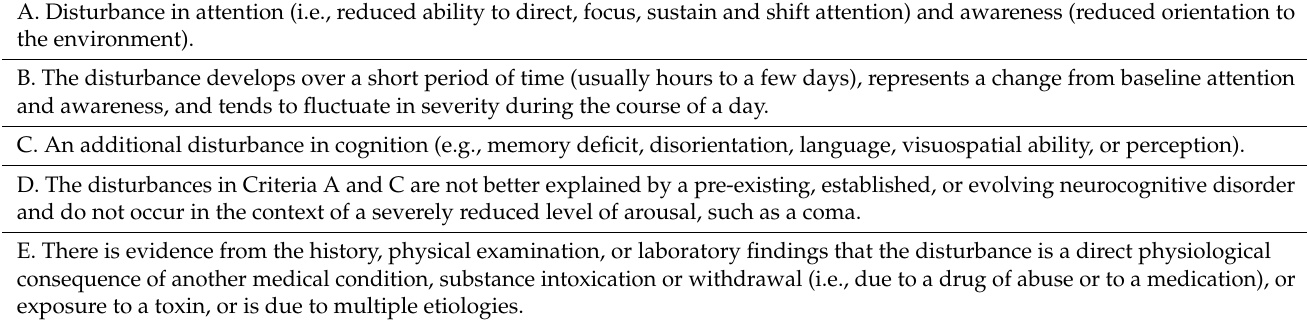
Table 1. Delirium criteria are based on the fifth edition of the Diagnostic and Statistical Manual of Mental Disorders (DSM-5)